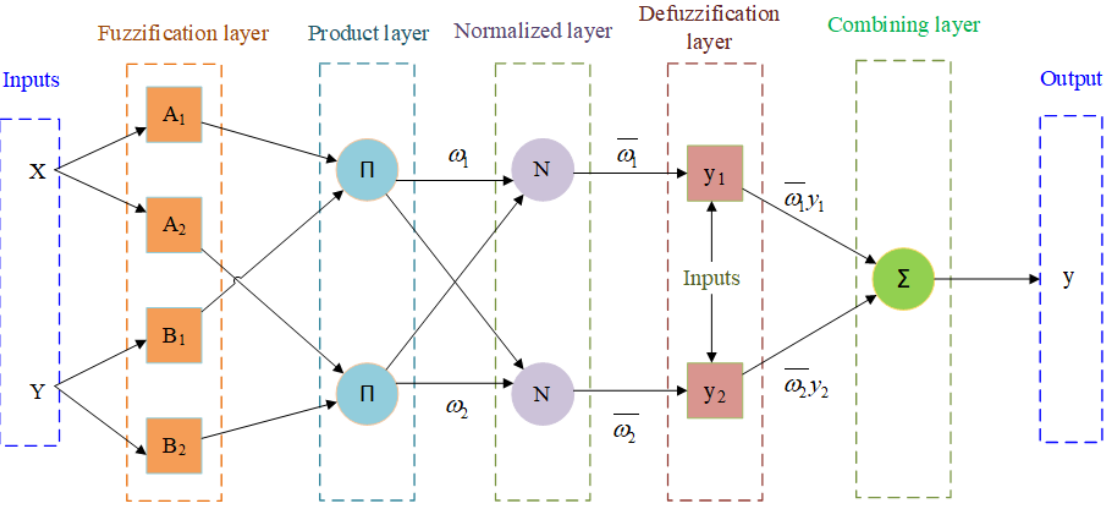
Figure 2. ANFIS framework.